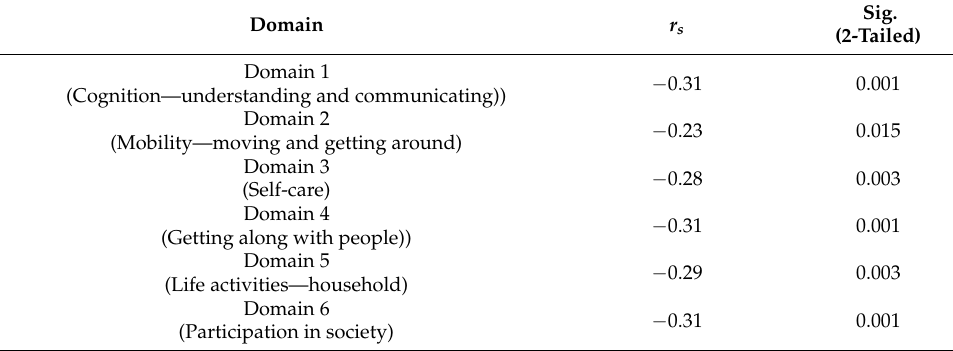
Table 3. Correlations with DSST.